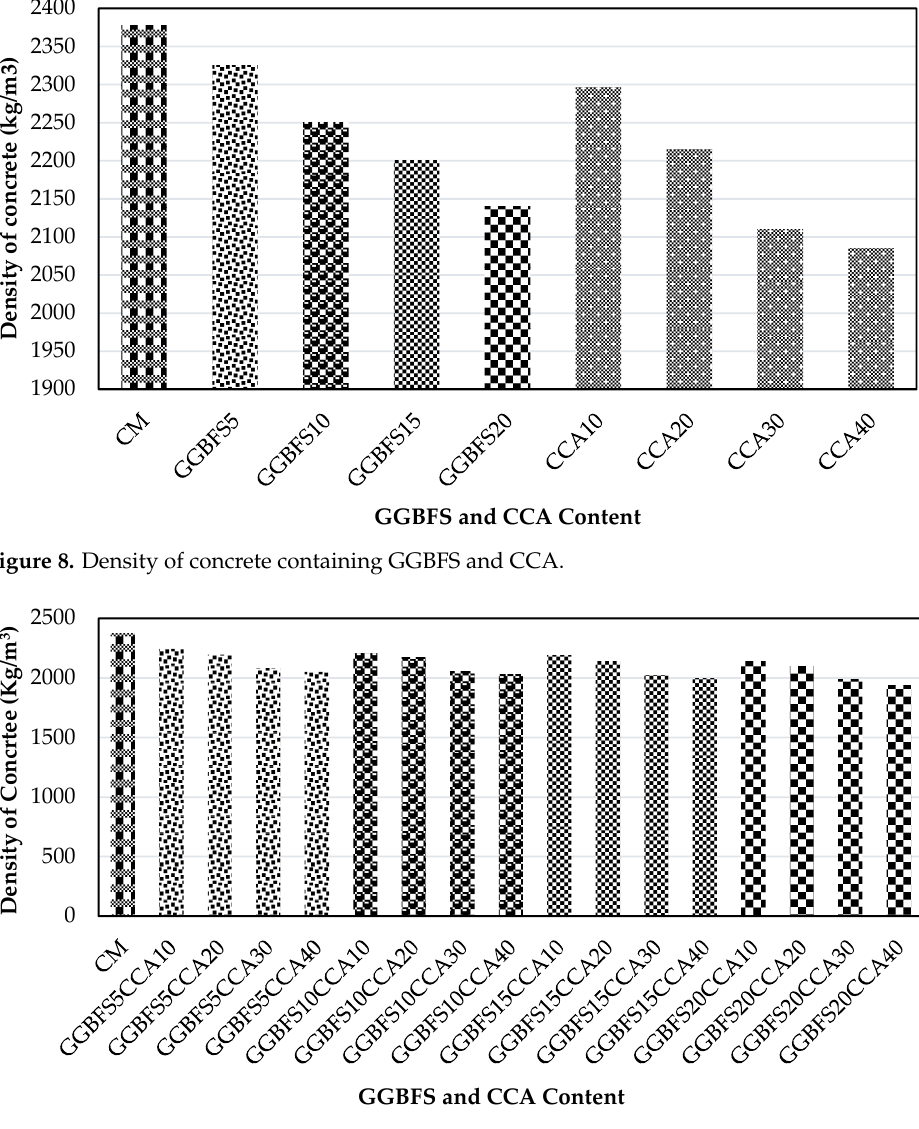
Figure 9. Density of concrete blended with GGBFS along with CCA.